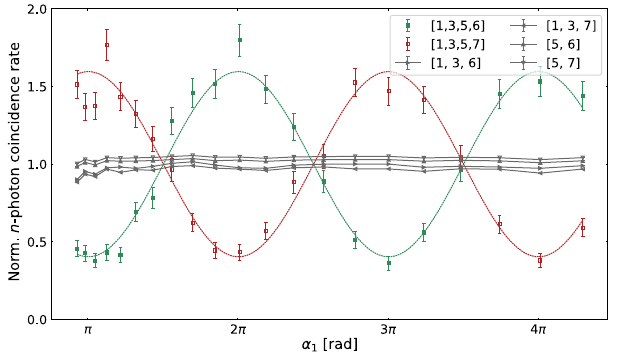
FIG. 11. Normalized rate of four-photon coincidences as a function of the internal phase of the CI, α 1 , for two output modes corresponding to constructive (destructive) interference, com- pared to a selection of normalized two- and three-photon coincidences. Note that the two- and three-photon coincidences have been normalized by the mean number of two-photon and three-photon coincidences, respectively, and offset by a constant value so they do not overlap on the plot. The four-photon interference data in this graph are taken from Fig.